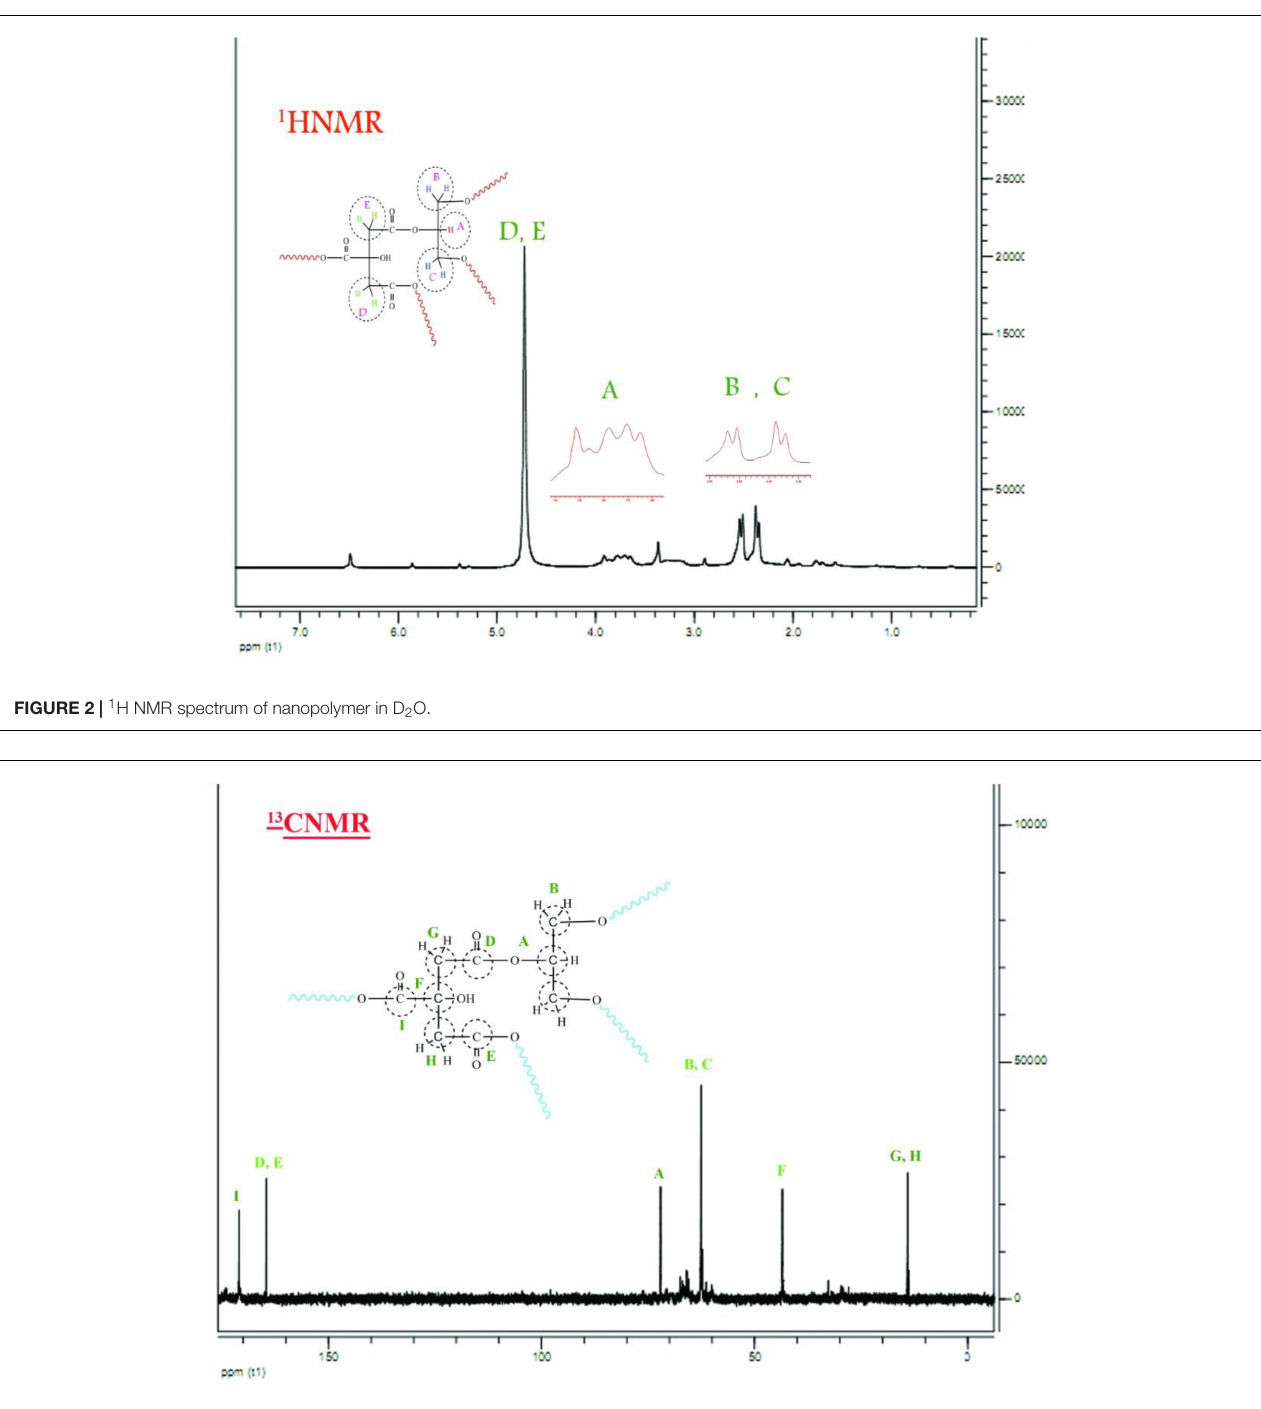
FIGURE 3 | 13 C NMR spectrum of nanopolymer in D 2